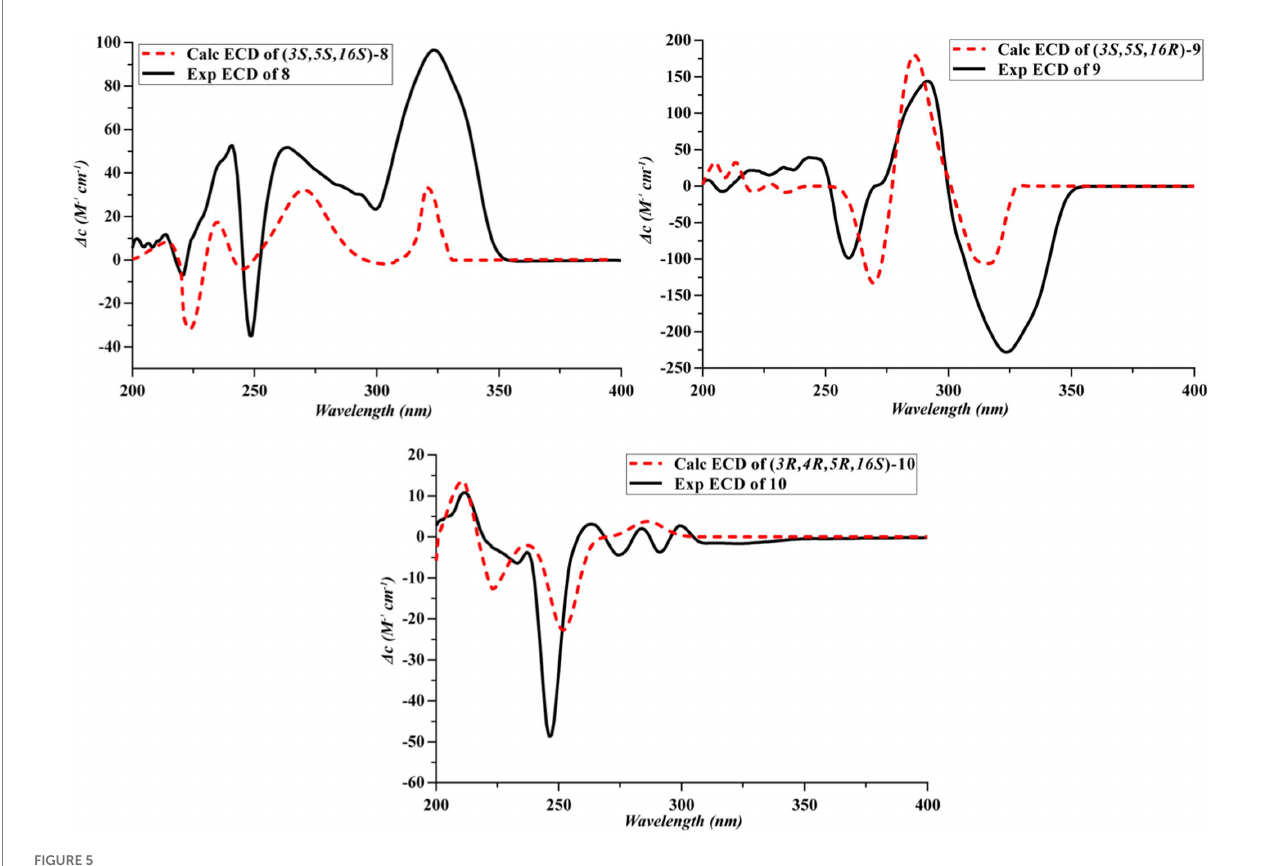
FIGURE 5 Experimental and calculated ECD spectra of 8 – 10